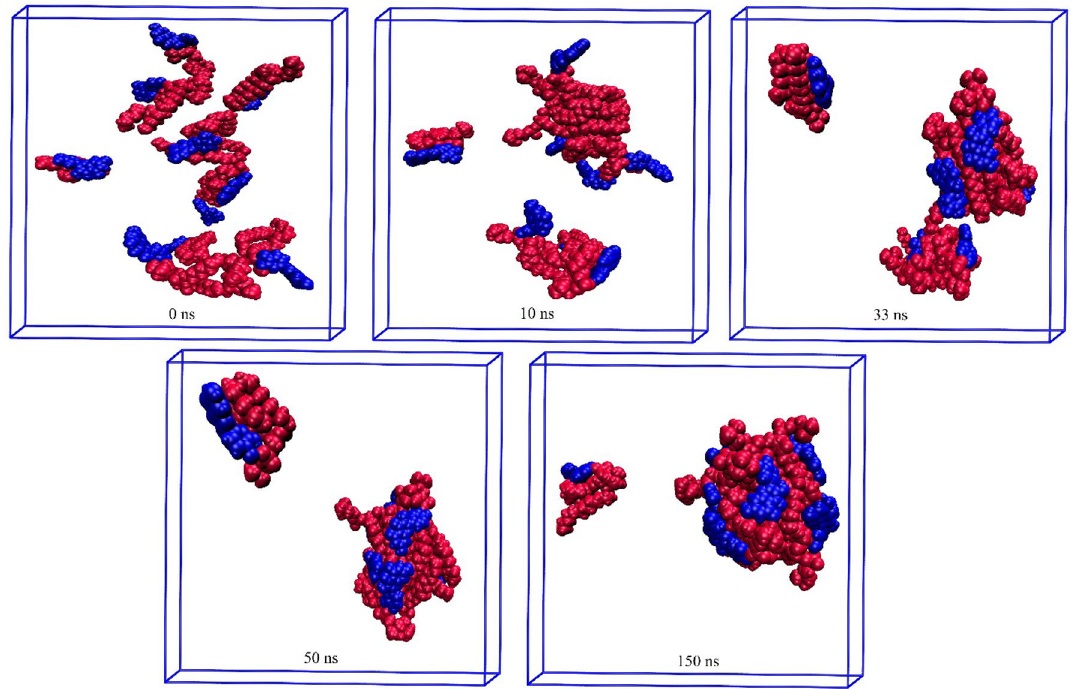
Figure 12. Self-aggregation process of Qu-PC monomers into a phytosome as a function of MD simulation time. Color code; Qu: blue and PC: red.